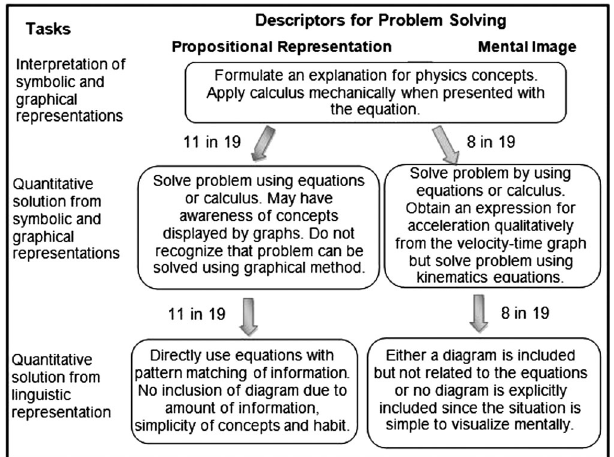
FIG. 2. Descriptors that define students within the profile for the category of propositional representation and mental image in kinematics.